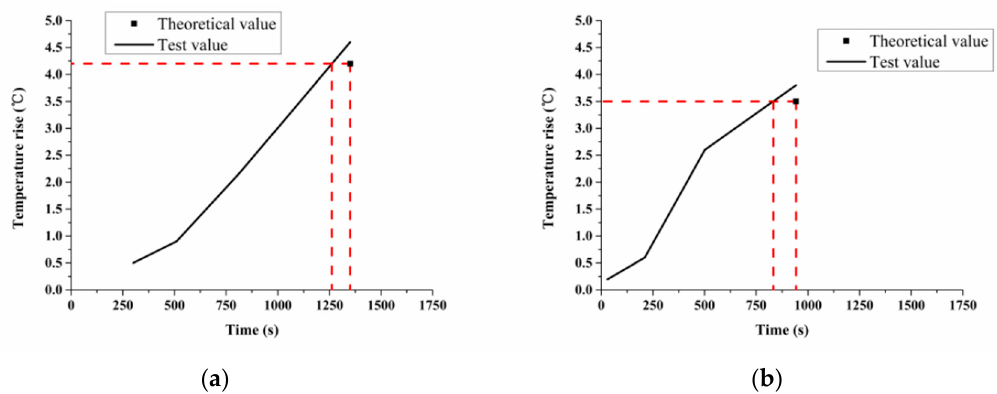
Figure 10. Temperature rise vs. time graph. ( a ) Comparison of the calculated and measured temperature jump of specimen A1; ( b ) Comparison of the calculated and measured temperature jump of specimen